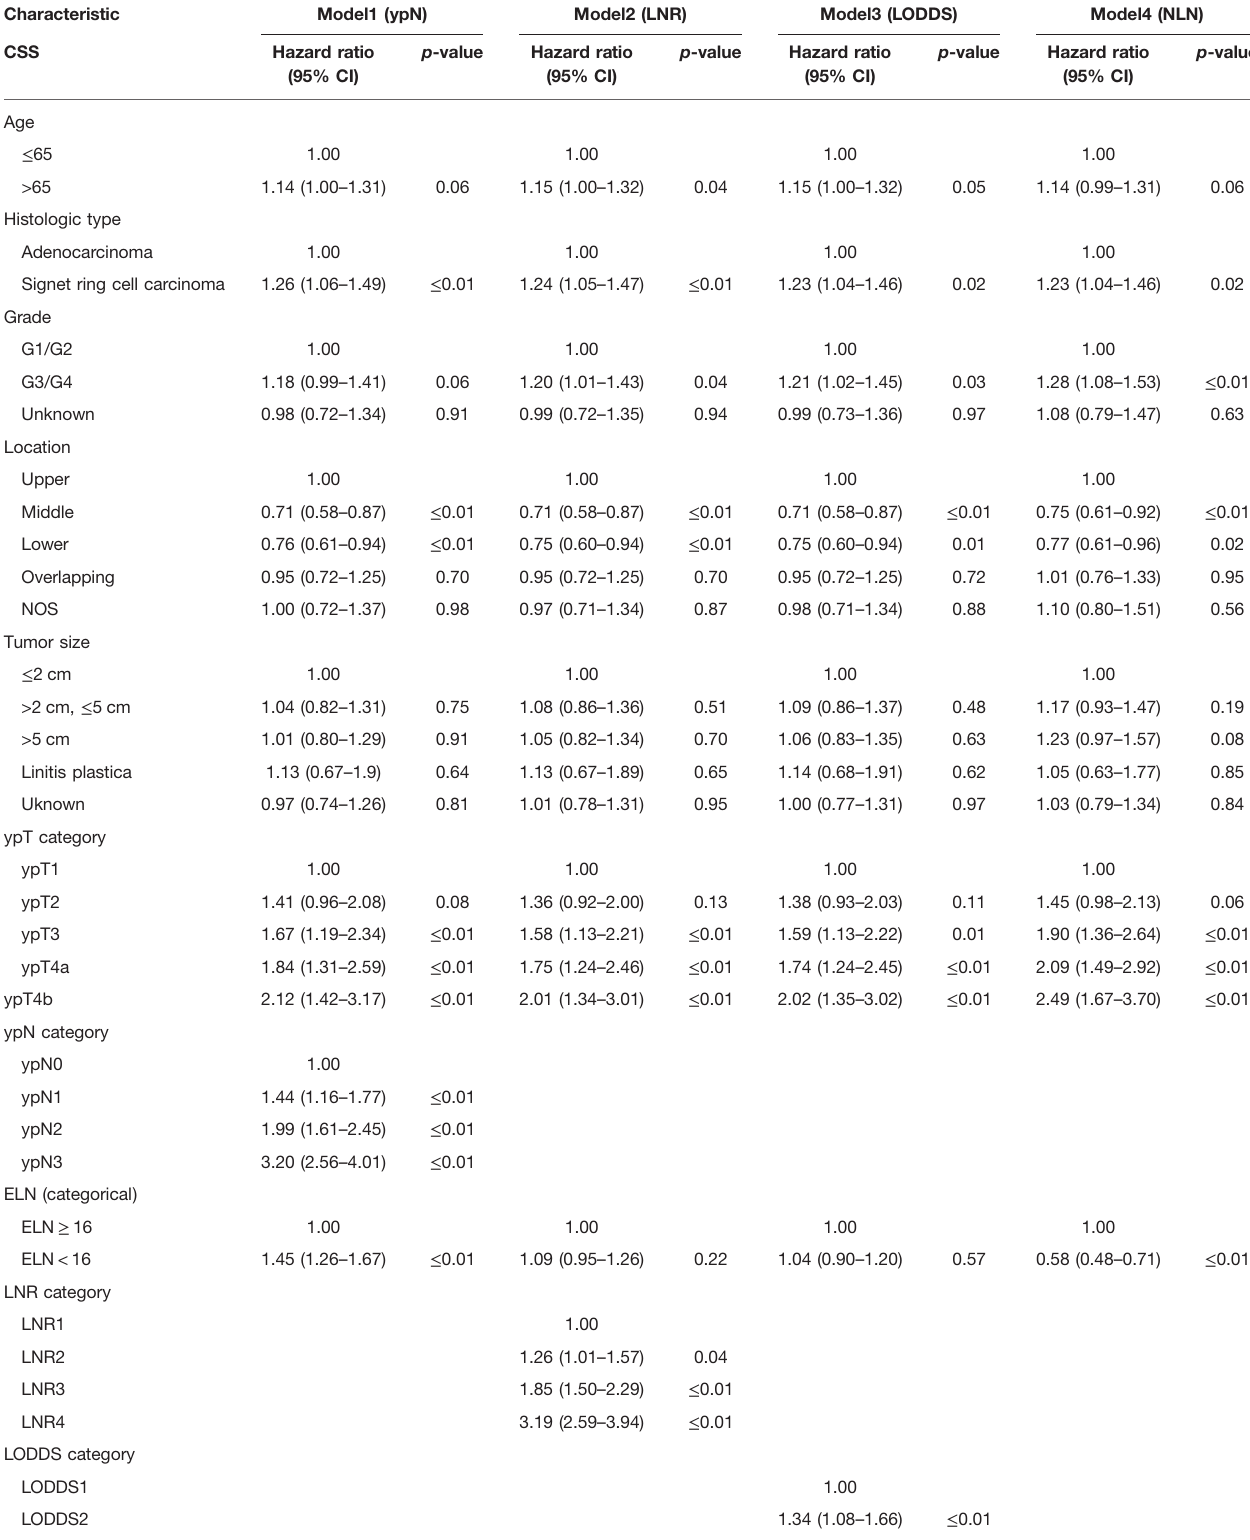
TABLE 3 | Multivariate Cox regression analysis of prognostic predictors for CSS in gastric adenocarcinoma patients after